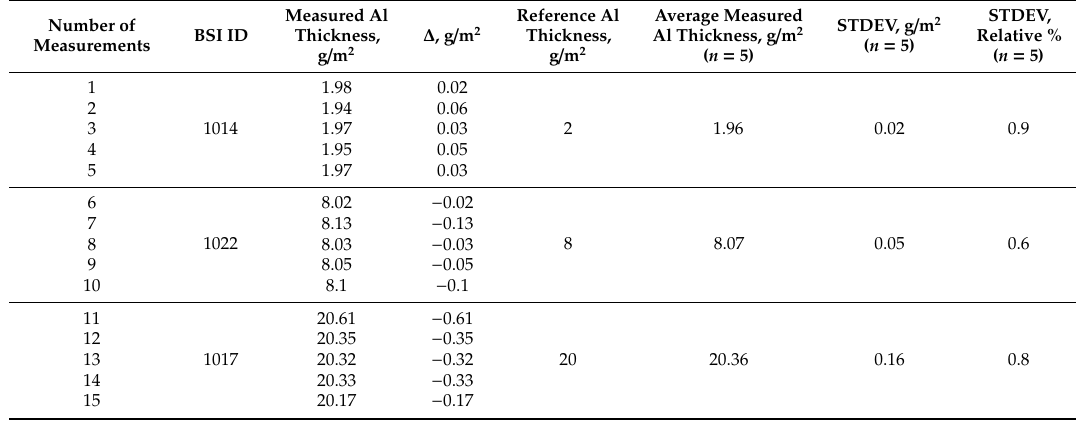
Table 1. Repeatability of Al coating thickness measurements ( n = 5).